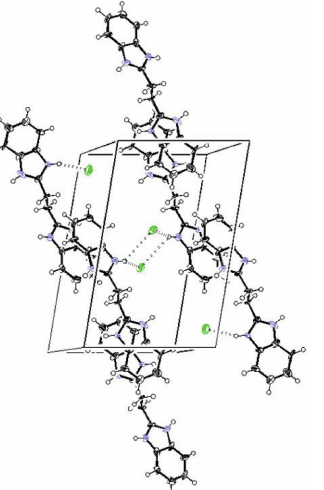
F 5: Unit cell packing diagram for compound 1 . Molecular overlap view from the